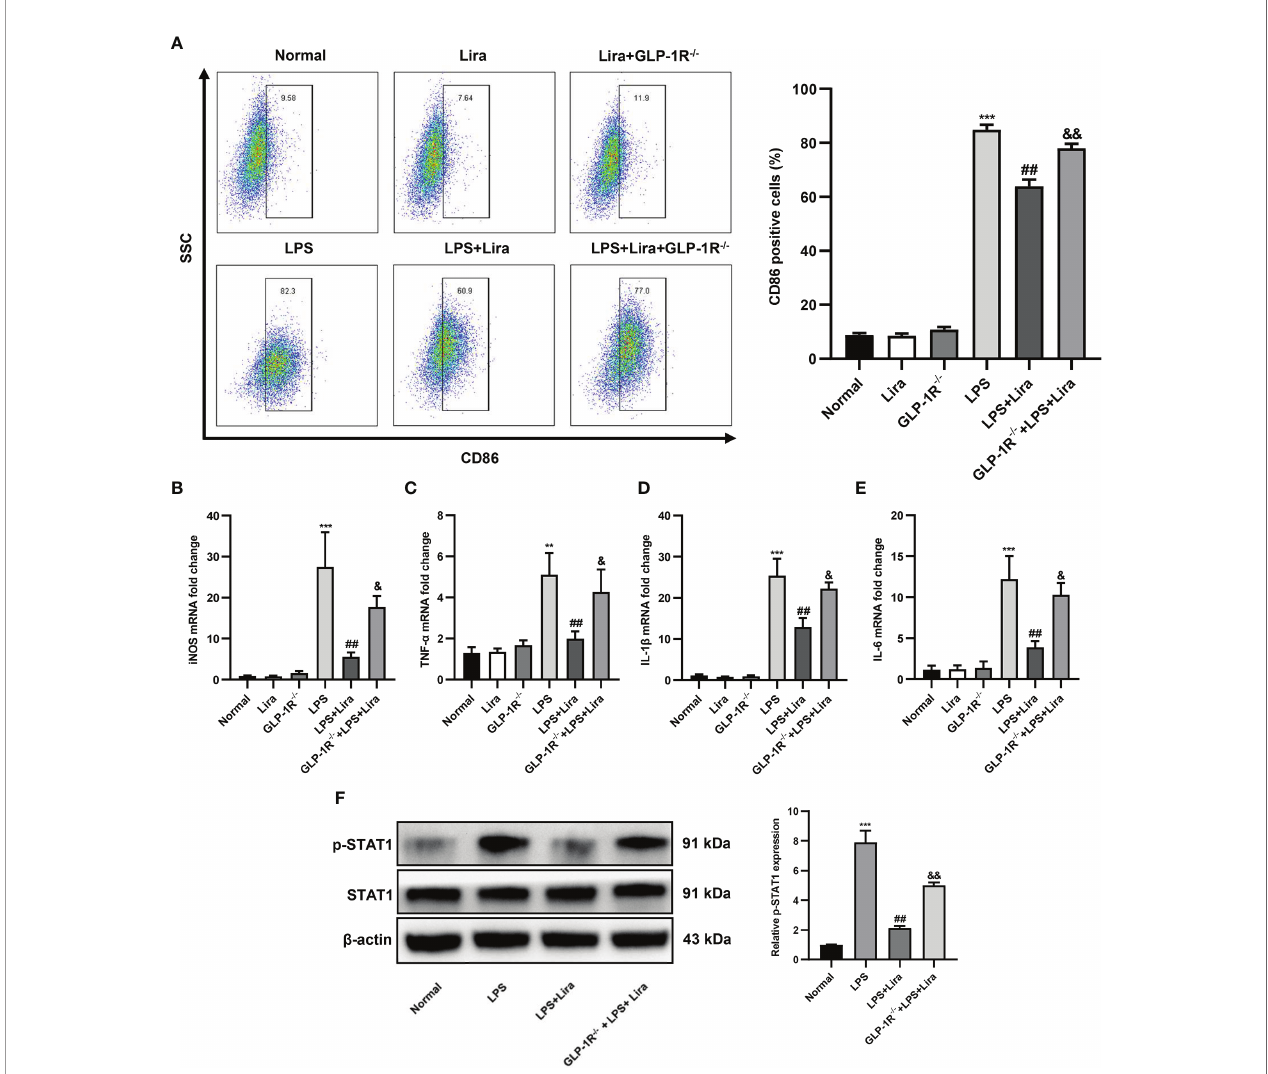
FIGURE 5 | Liraglutide pretreatment reduces LPS-induced M1 polarization in vitro . BMDMs from GLP-1R -/- and C57BL/6J mice were isolated and cultured for in vitro study. The cells were pretreated with liraglutide (50 µm) for 24 h, stimulated with LPS (100 nm) for 24 h, and the expression pro fi les of M1 in BMDMs in each group were analyzed via fl ow cytometry, RT-PCR, and western blotting. (A) The number of CD86 + -positive cells of BMDMs under F4/80 + and CD11b + subsets was calculated via fl ow cytometry. The mRNA levels of iNOS (B) , TNF- a (C) , IL-1 b (D) , and IL-6 (E) were measured via qRT-PCR. (F) The phosphorylation of STAT1 was analyzed via western blotting. Similar results were obtained from at least three independent experiments. Data are expressed as mean ± SD, n = 3 per group. **P < 0.01, ***P < 0.001 vs. the Normal group; ## P < 0.01 vs. the LPS group. & P < 0.05, && P < 0.01 vs. the LPS+Lira group. BMDMs, bone marrow derived